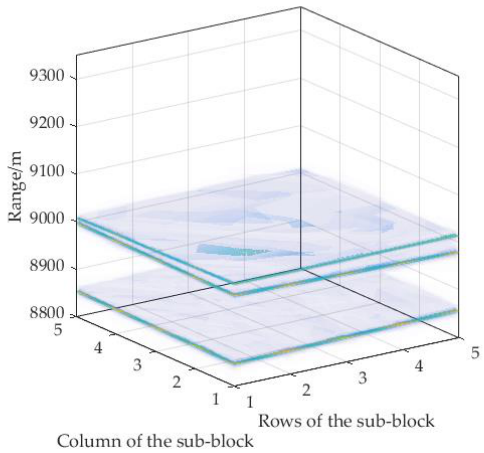
Figure 5. Range profiles of a sub-block in 3D Figure 5. range profiles of a sub-block in 3D space.